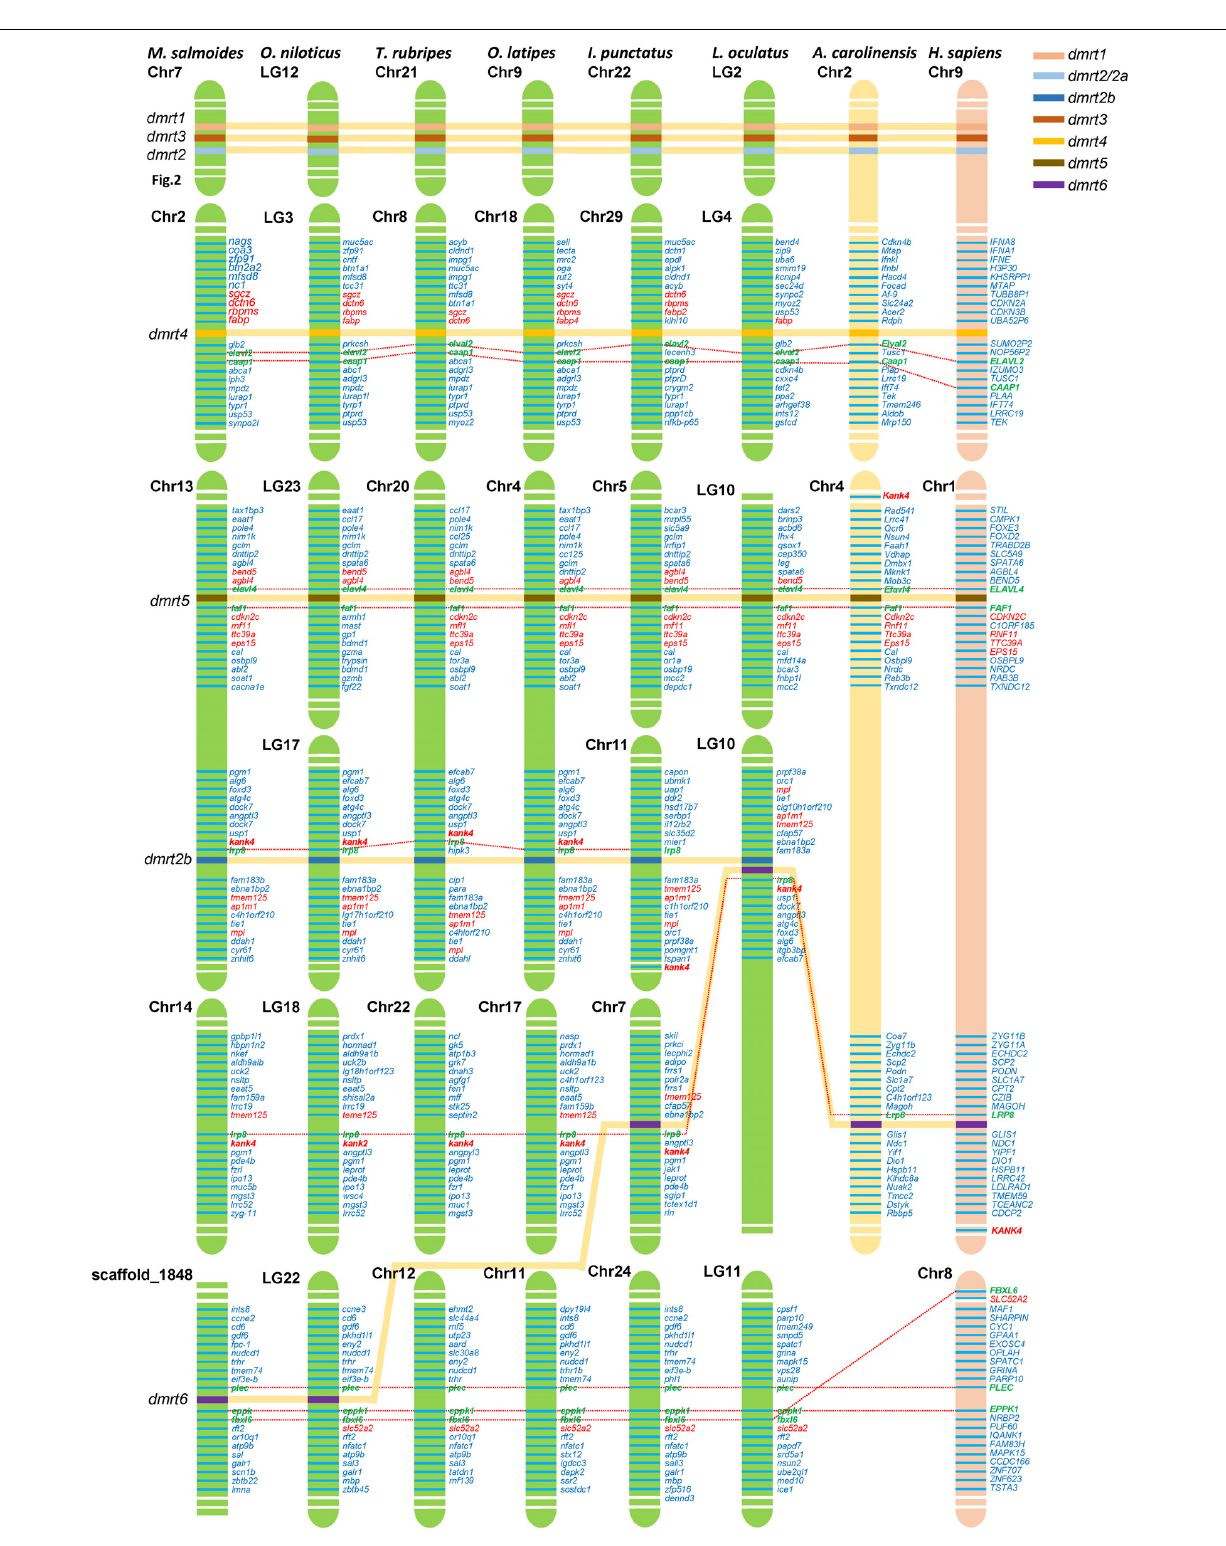
Frontiers in Genetics |